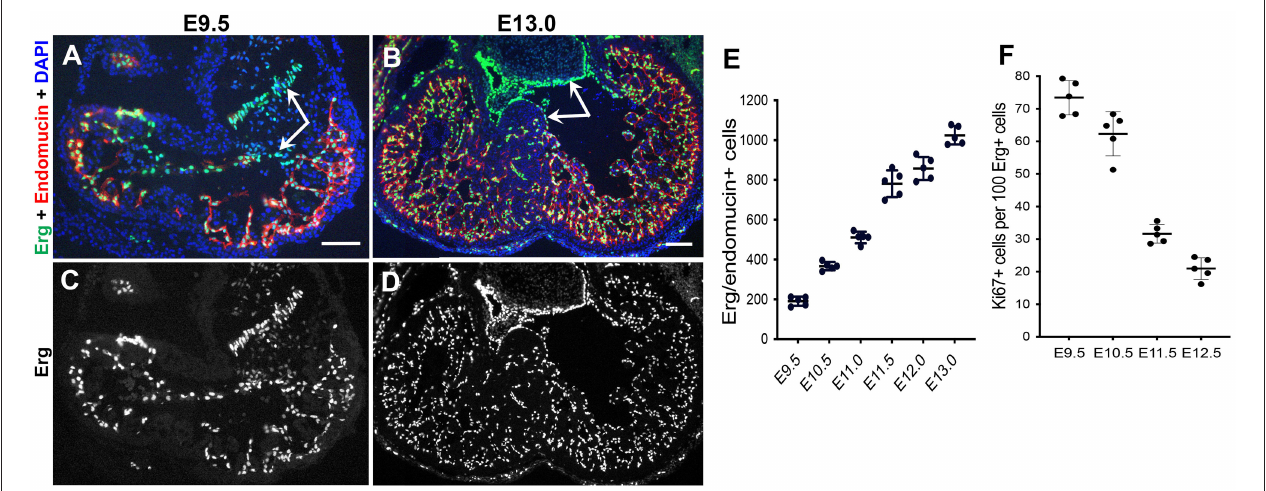
FIGURE 3 | Rapid expansion of the endocardium during trabeculation. (A–D) Dual immunostaining of wildtype mouse heart sections for the endothelial-specific ETS transcription factor Erg (green) and the endothelial marker endomucin (red) at E9.5 and E13.0. The endocardial cells in the ventricles display high expression of endomucin, but a subset of endocardial cells undergoing EndoMT to form the mesenchymal cells of the cardiac valves are negative for endomucin (arrows). Scale bars, 100 µ m. (E) Quantification of the total number of endocardial cells (Erg + /endomucin + cells) indicates a rapid expansion of endocardial cells from E9.5–E13.0 during trabeculation. (F) However, quantification of endocardial proliferation (Ki67/Erg-positive cells) after dual immunostaining of wildtype heart sections for Ki67 and Erg at E9.5–E12.5 shows a decrease in relative endocardial cell proliferation as trabeculation